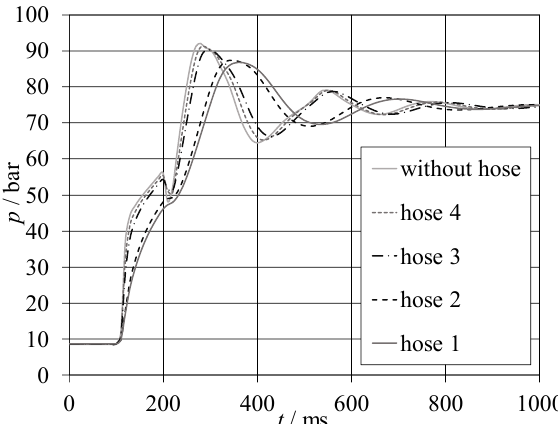
Fig. 5. Simulation of parallel capacitance influence